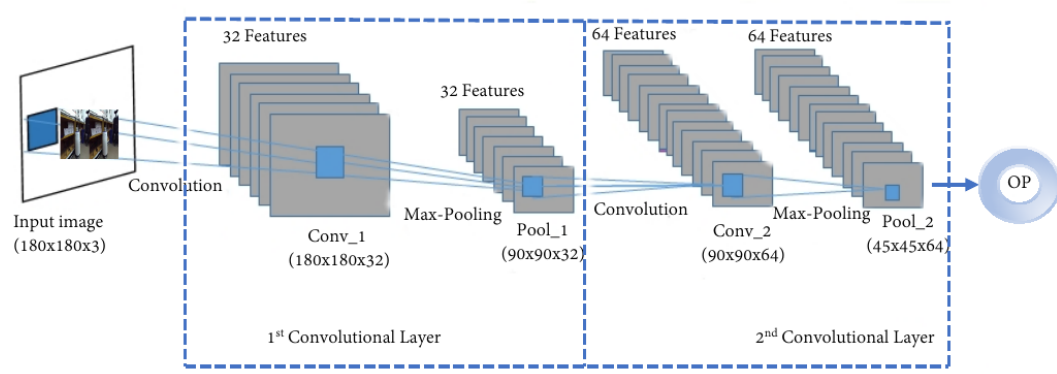
Figure 7. Data flow in the first two layers of a convolutional neural network